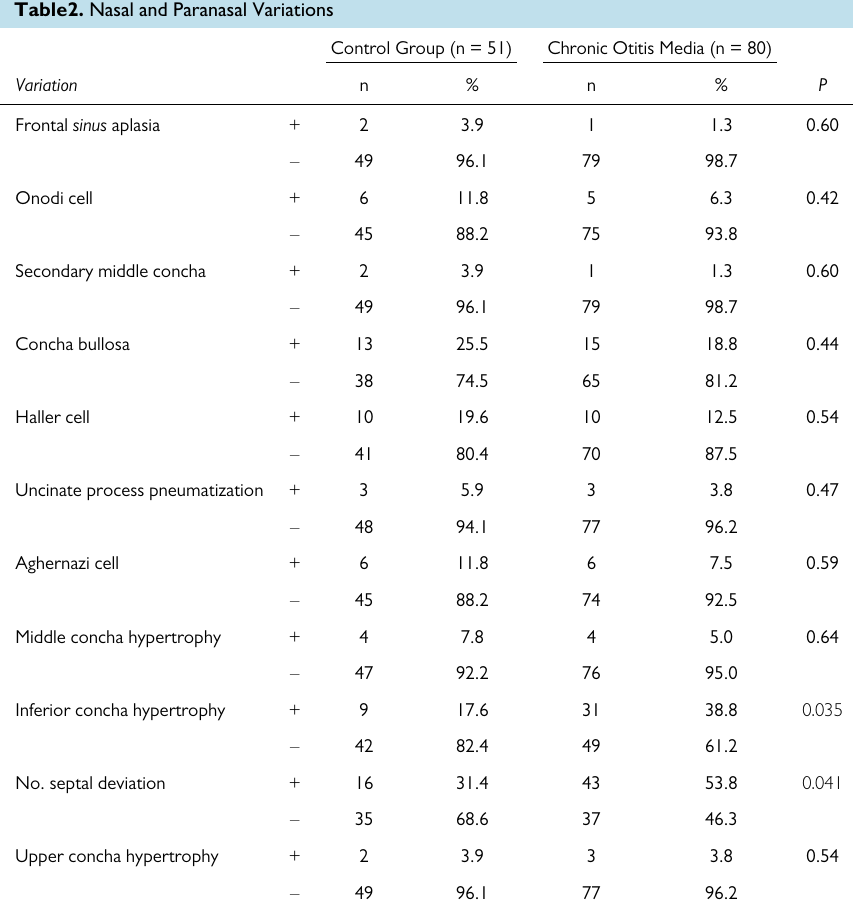
Table2. Nasal and Paranasal Variations Control Group (n = 51) Chronic Otitis Media (n =